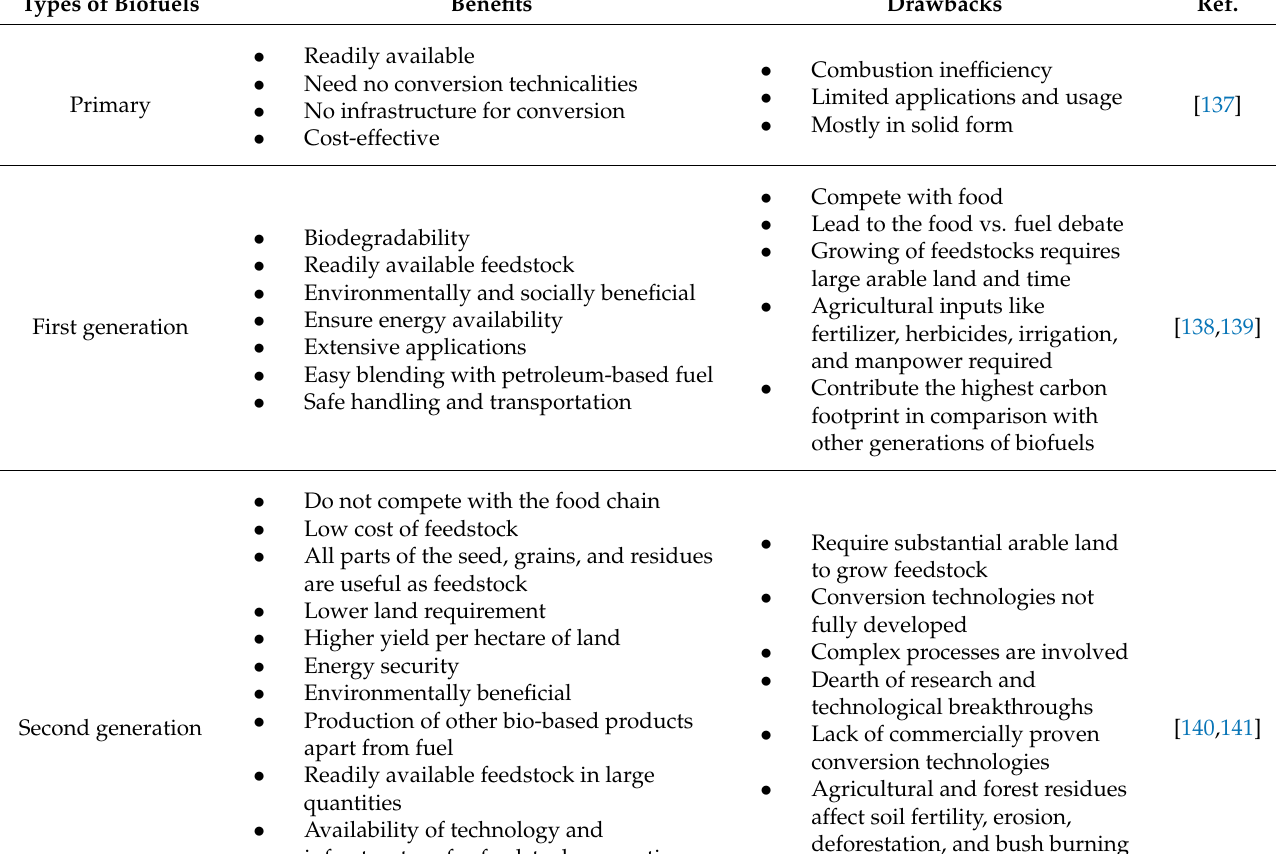
Table 4. Benefits and drawbacks of each generation of biofuels. Benefits Drawbacks